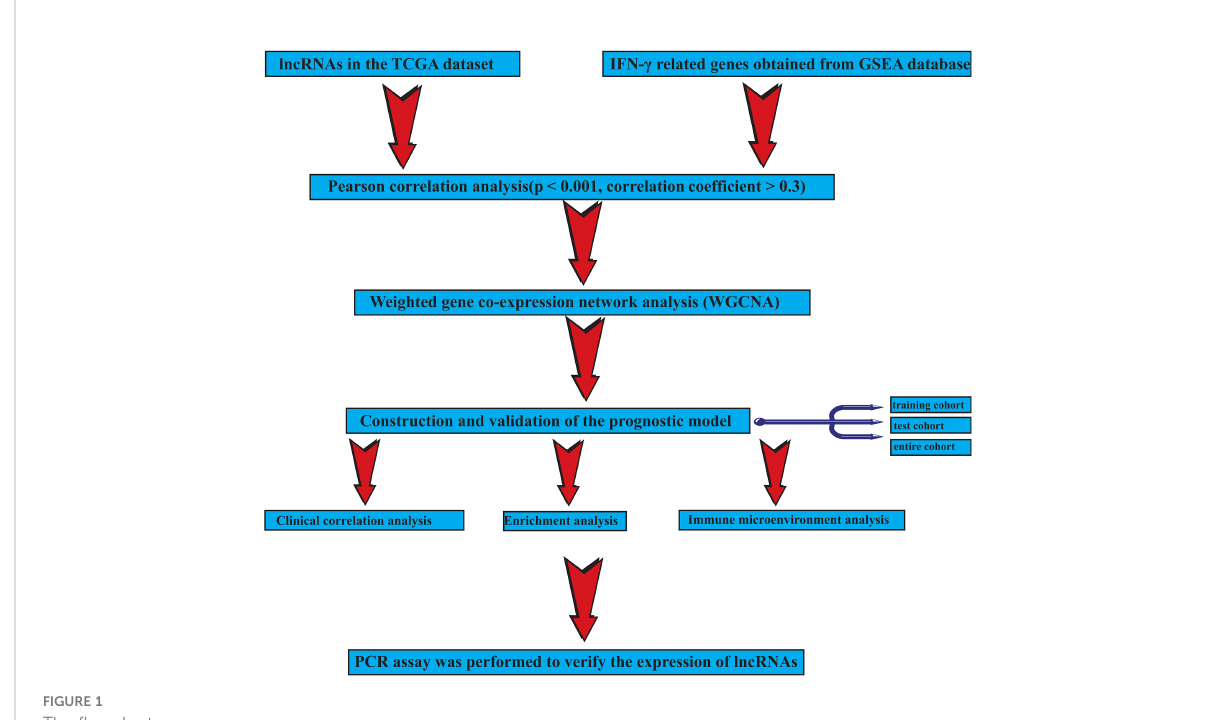
FIGURE 1 The fl